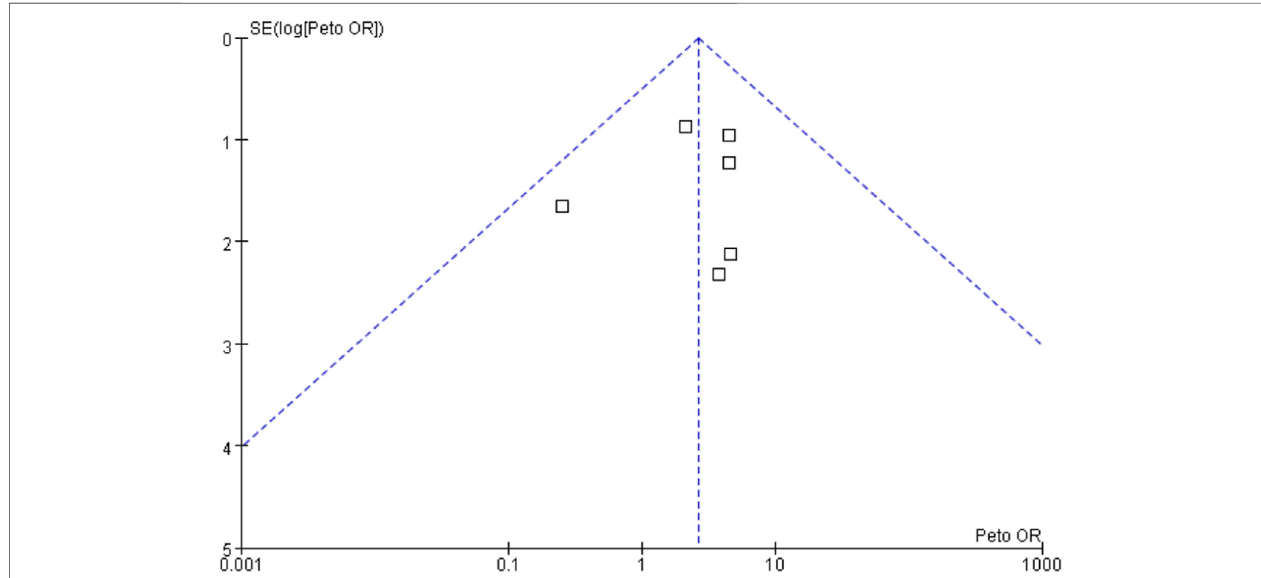
FIGURE 4 | Publication bias based on overall neoplasms in patients treated with fostamatinib versus placebo.